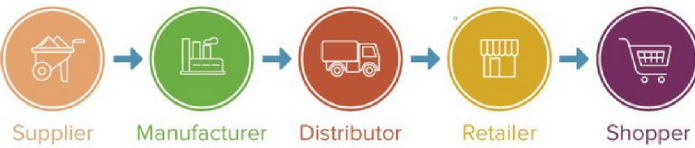
Figure 1. Supply chain